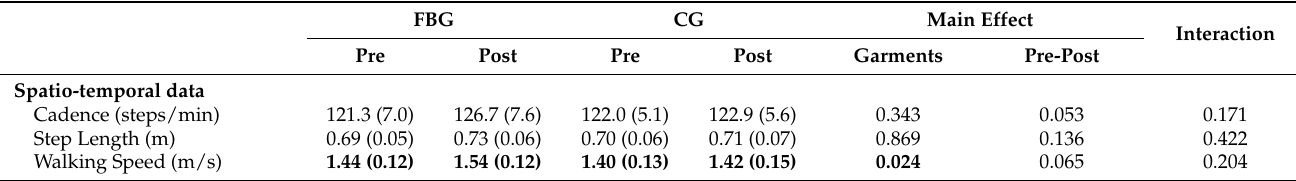
Table 4. Spatio-temporal data, during walking under two garments condition, i.e., effect of wearing comparison FBG and CG, average (SD), two-way ANOVA, p values < 0.05 are